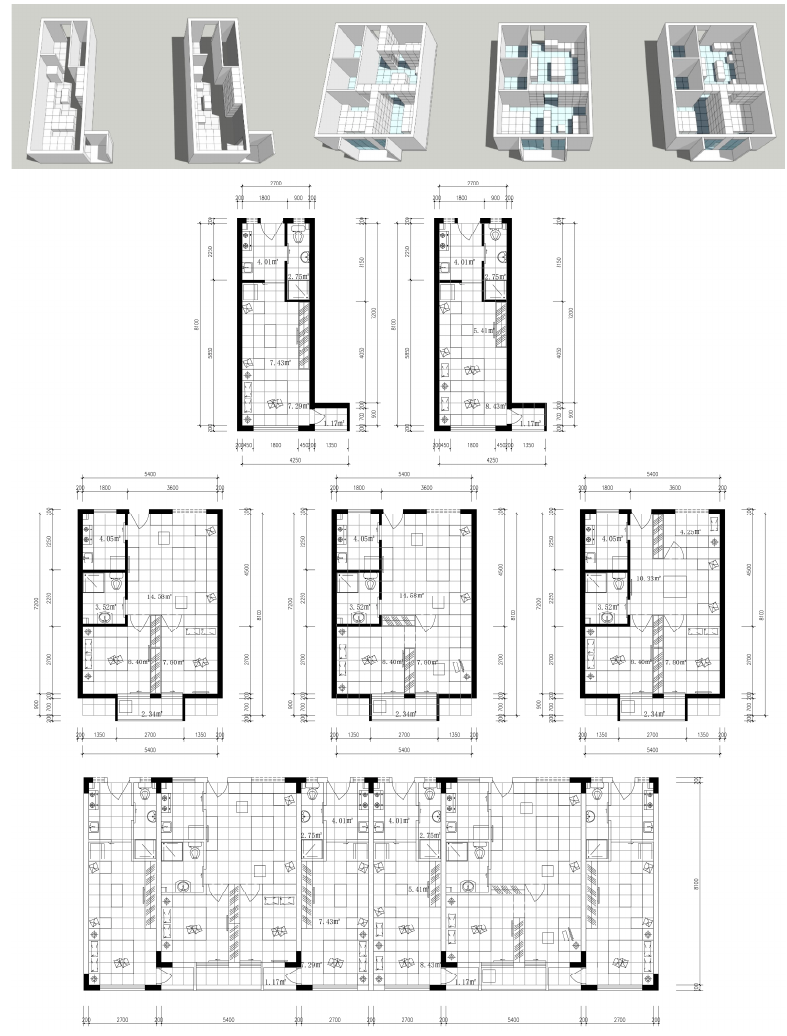
Figure 7. BOX450: One design of a flexible space layout (N0.17). Note: The selection of the basic modulus is as follows: According to the relevant data in GB 10000-88 Human Dimensions of Chinese Adults, select a group of data, select 450 mm as the minimum modulus, and further combine them to form other different furniture